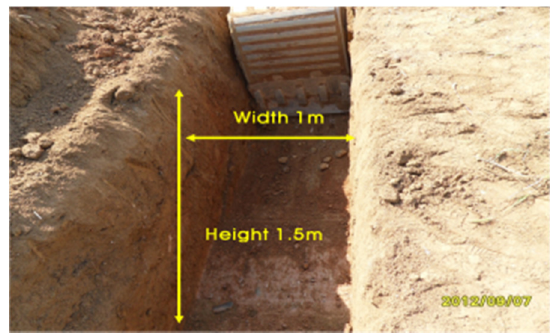
Figure 11. Trench excavation for the plastic